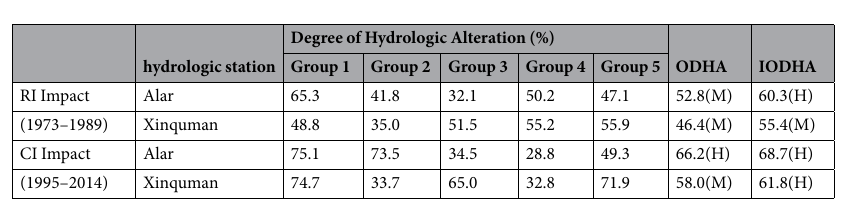
Table 4. Overall degree of hydrological alteration in the Tarim River for the RI impact and the CI impact. Note: ODHA represents the overall degree of hydrological alteration estimated with Equation (3) and IODHA is for the improved overall degree of hydrological alteration estimated with Equation (4). For each group, the degree of hydrologic alteration (DHA) was estimated using Equation